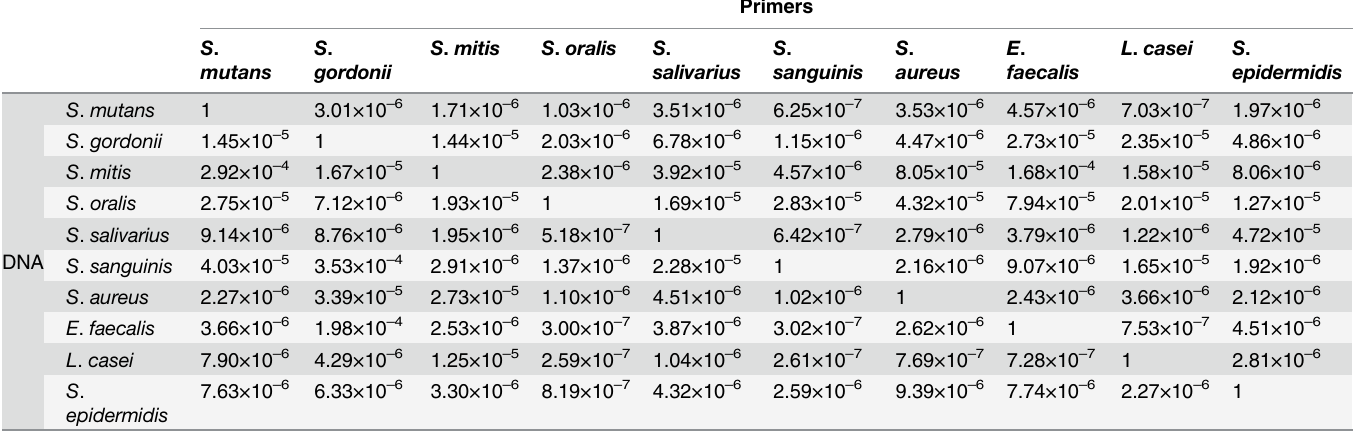
Table 2. Validation Range Test of the Method.